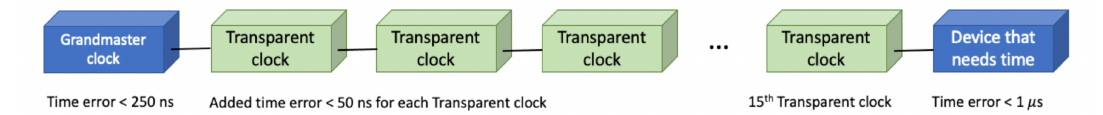
Figure 3. The timing performance requirements of the Power Utility Profile. A device that requires precise time, such as a phase measurement unit, can be 15 Ethernet switches away from the PTP Grandmaster and still obtain a maximum received time error of 1 µ